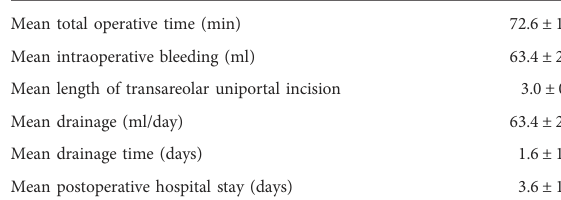
TABLE 3 Perioperative outcomes. Characteristics